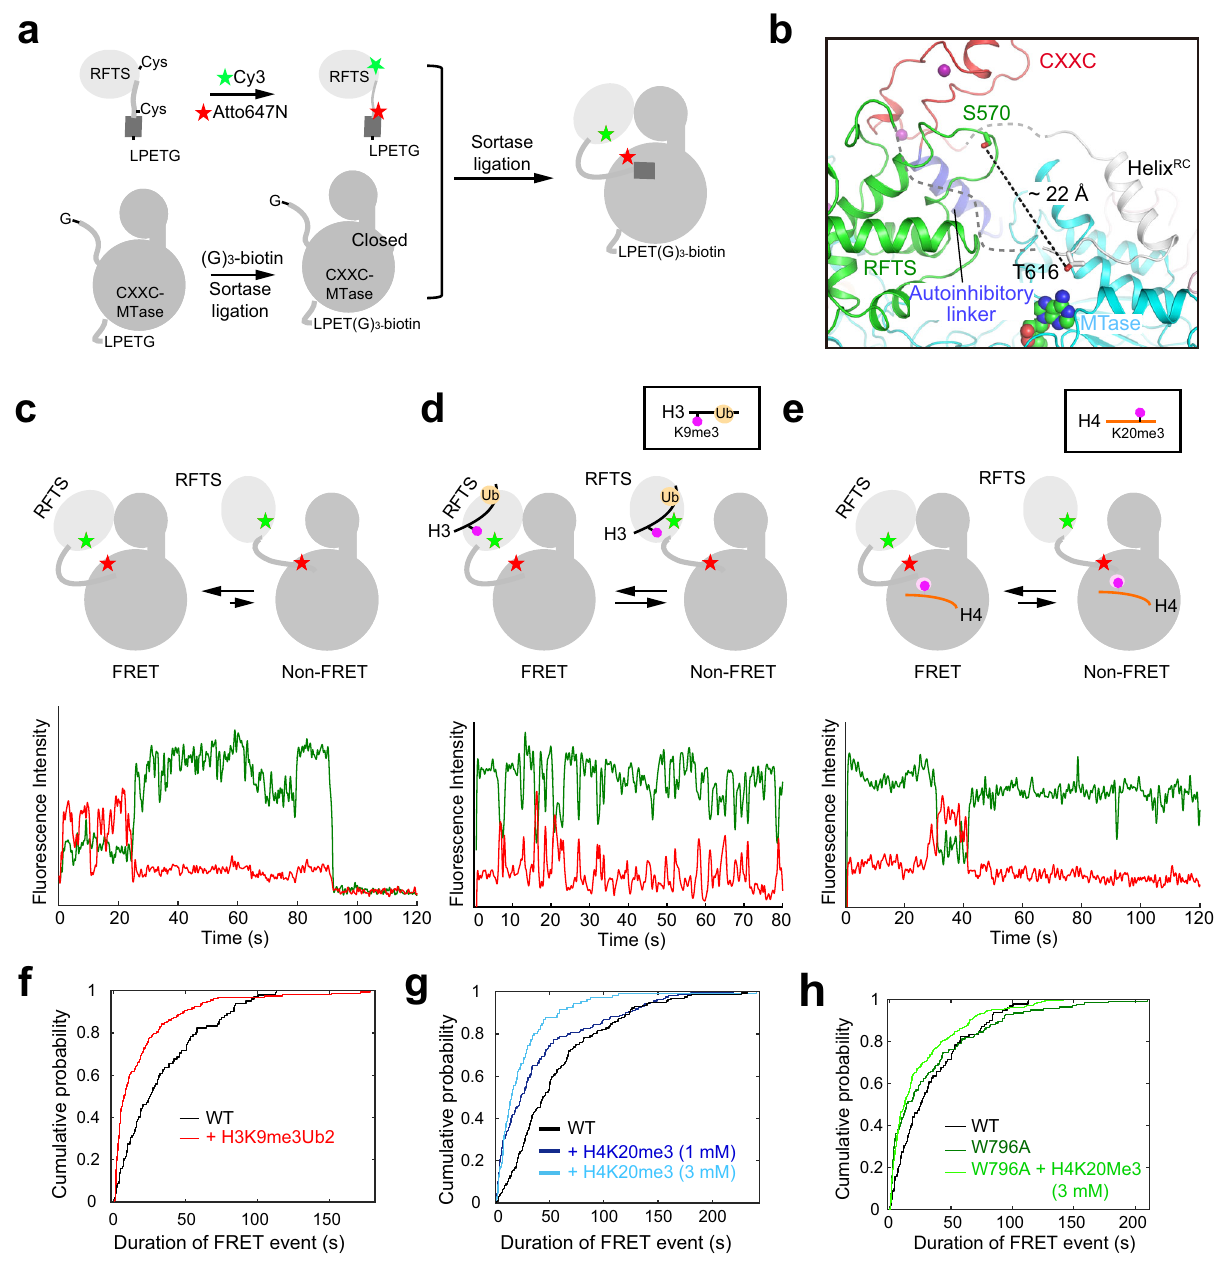
Fig. 3 smFRET analysis of the conformational dynamics of DNMT1 upon H3K9me3Ub2 or H4K20me3 binding. a Schematic view of the preparation of Cy3/Atto647N-labeled hDNMT1 fragment (hDNMT1 CY ) for smFRET analysis. The Cy3 and Atto647N dyes are shown as green and red stars. The Helix RC is shown as cylinder in dark gray. The RFTS domain and the rest of DNMT1 are colored light gray and gray, respectively. b Close-up view of the autoinhibitory state of hDNMT1 351 – 1600 (PDB 4WXX [10.2210/pdb4WXX/pdb]), with the distance between S570 and T616 indicated by a dashed line in black. The linker connecting the RFTS and CXXC domains is in gray, with dashed lines indicating disordered regions. c (Top) Model for the conformational transition between autoinhibited and activated hDNMT1 CY . (Bottom) Representative smFRET trace observed for peptide-free wild-type hDNMT1 CY . d (Top) Model for the conformational transition between autoinhibited and activated conformations of H3K9me3Ub2-bound hDNMT1 CY . The H3K9me3 and ubiquitin marks are shown as magenta and wheat spheres, respectively. (Bottom) Representative smFRET trace observed for hDNMT1 CY in the presence of H3K9me3Ub2. e (Top) Model for the conformational transition between autoinhibited and activated conformations of H4K20me3-bound hDNMT1 CY . The H4K20me3 mark is shown as magenta sphere. (Bottom) Representative smFRET trace observed for hDNMT1 CY in the presence of H4K20me3. f Cumulative probability of the durations of FRET events observed for hDNMT1 CY , in the absence (black) or presence (red) of H3K9me3Ub2 peptide (97 and 93 molecules, respectively). g Cumulative probability of the durations of FRET events observed for hDNMT1 CY , in the absence (black, 150 molecules) or presence of 1 mM (blue, 119 molecules), or 3 mM (cyan, 88 molecules) H4K20me3 peptide. h Cumulative probability of the durations of FRET events observed for peptide-free WT hDNMT1 CY (black, 97 molecules), compared with W796A hDNMT1 CY in the absence (dark green, 95 molecules) or presence (light green, 164 molecules) of 3 mM H4K20me3 peptide.